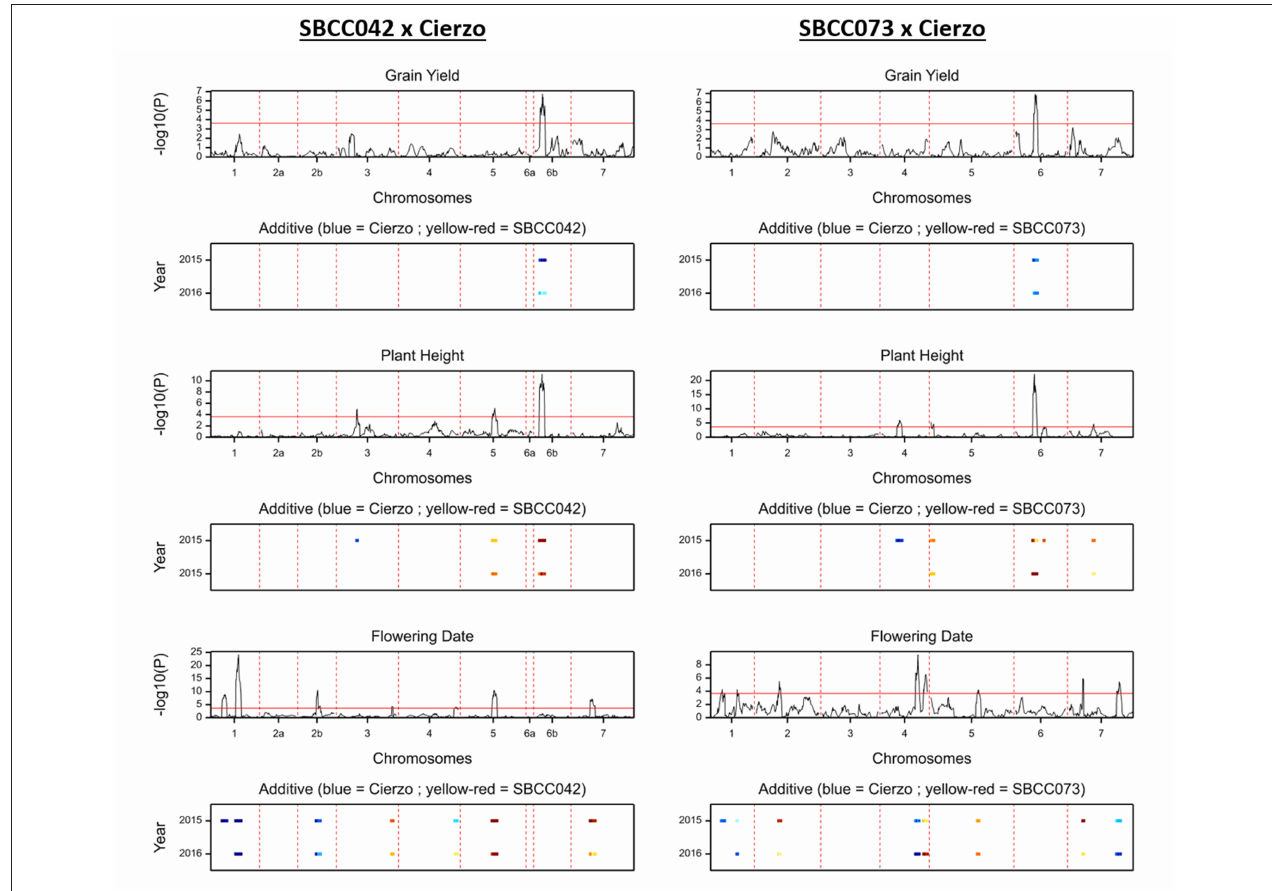
FIGURE 2 | QTL scans of the whole genome for the traits measured in two seasons: grain yield, plant height and flowering date, from top to bottom; SBCC042 × Cierzo on the left, and SBCC073 × Cierzo is on the right. For each trait, the top graph represents the test statistic (–log10 of the P -value) against genetic distance (cM) for the seven chromosomes. The bottom graph indicates the width of the QTL peak in each season, and the color indicates the strength and direction of the effect: blue shades indicate that Cierzo is the trait increasing allele, and yellow to red shades indicate that the landrace allele increases the